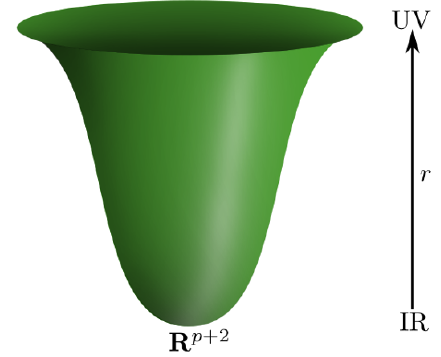
Figure 3 . The regular geometries interpolate between (cid:13)at Euclidean D p -branes in the UV and R p +2 in the